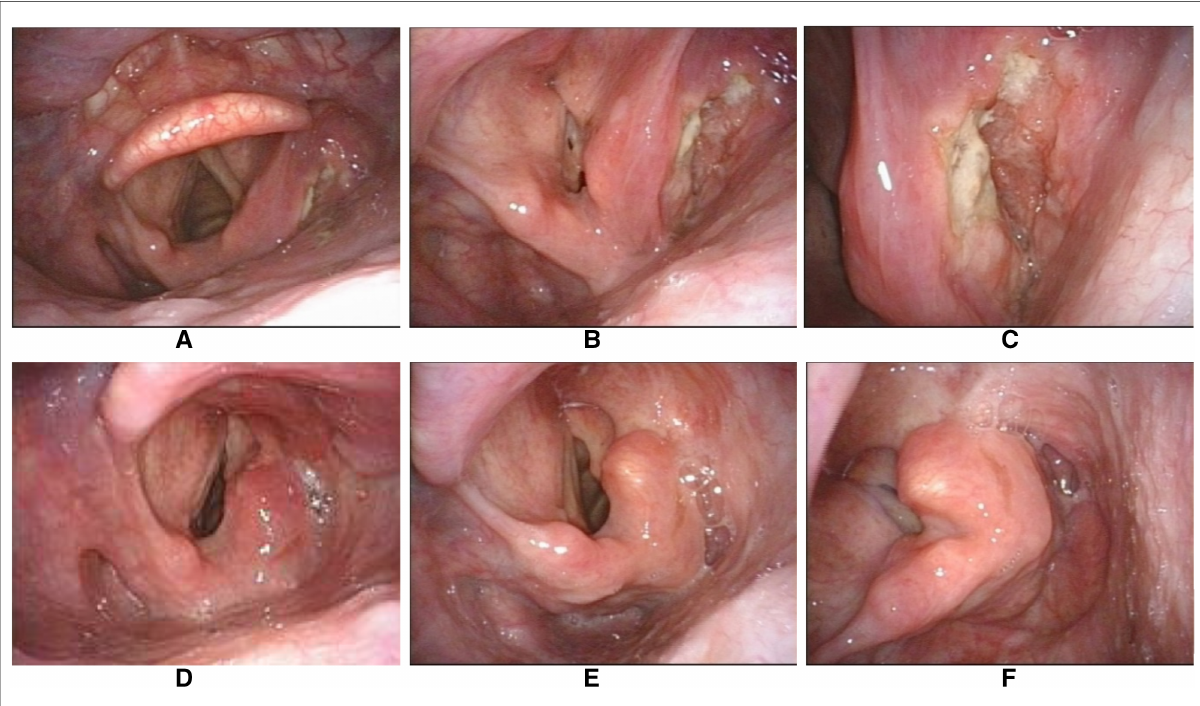
FIGURE 5 Representative pre-and postoperative laryngoscopic images of the same case. ( A – C ) The preoperative examination showed the tumor was con fi ned to the right pyriform sinus without involving the laryngeal cavity. ( D ) The anastomotic stoma of the right pyriform sinus still appeared edematous 3 months after the operation. ( E,F ) No tumour recurrence at 2 years post-operative